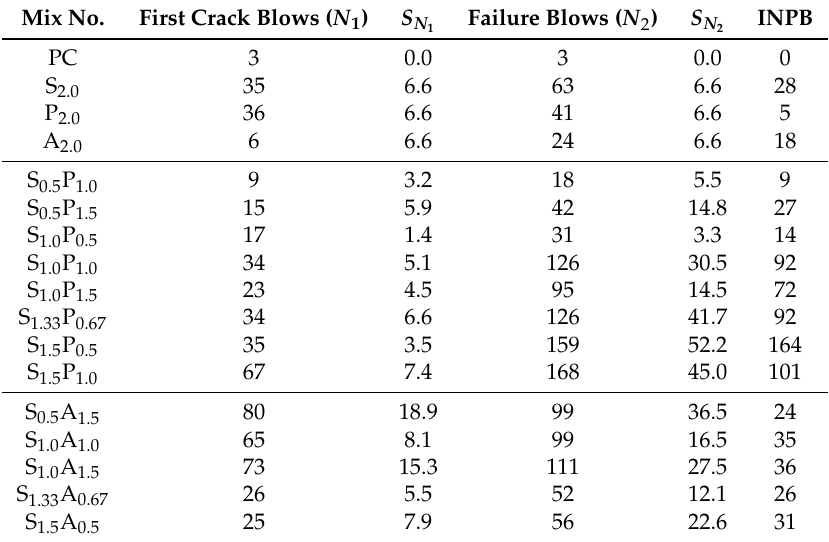
Table 4. Drop weight impact test results.